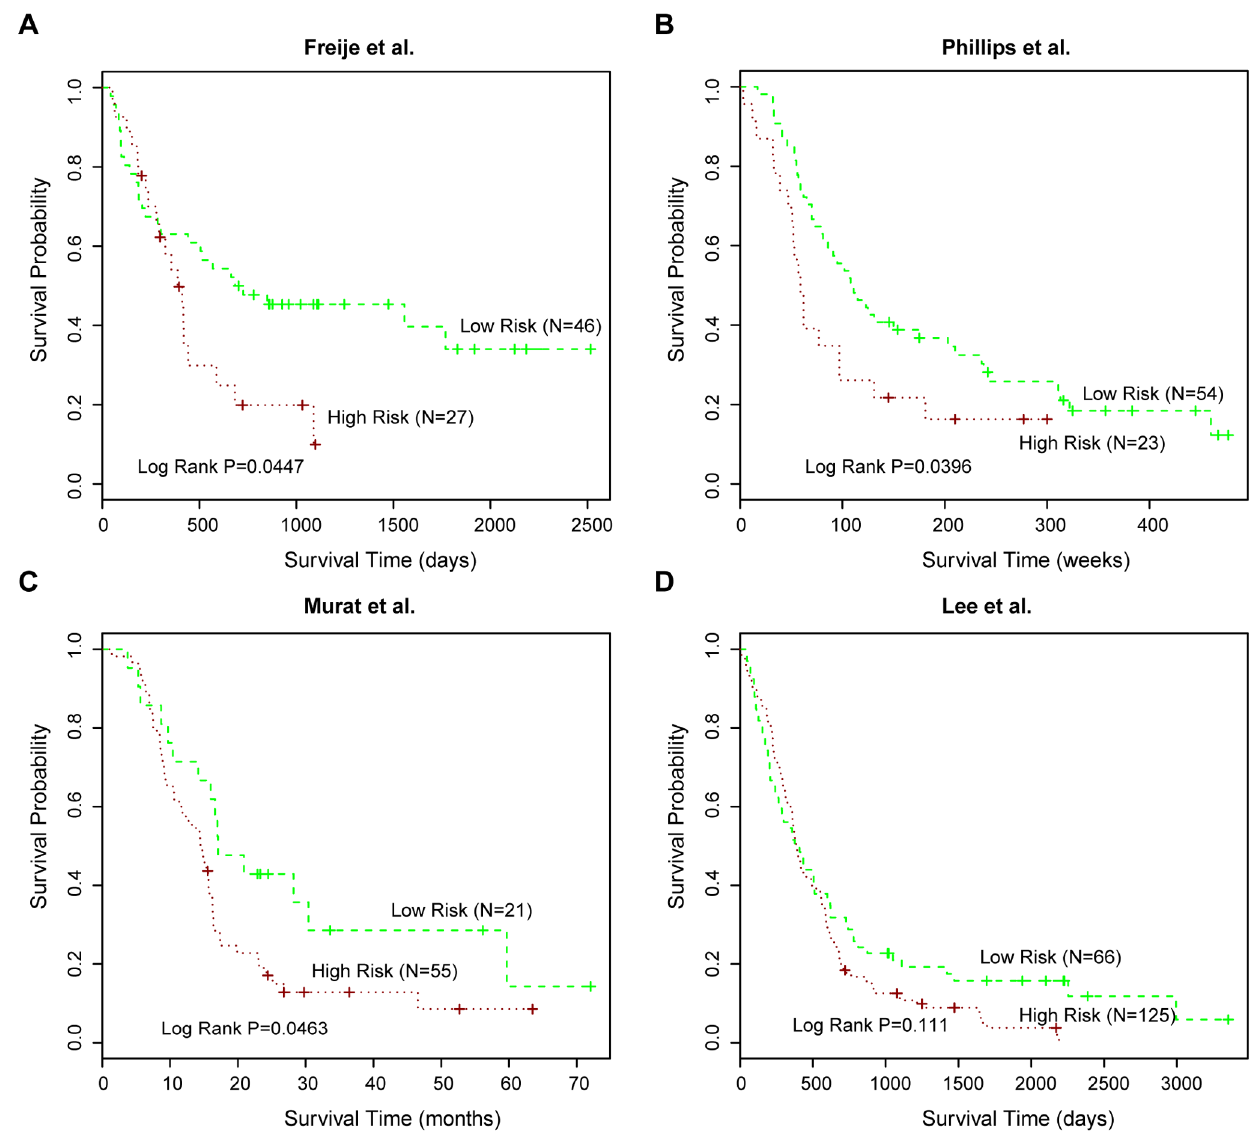
Figure 4. The gene signature from moduleS3 predicts clinical outcome of glioma datasets from GEO. The glioma datasets were respectively extracted from the studies of ( A ) Freije et al., ( B ) Phillips et al., ( C ) Murat et al., and ( D ) Lee et al.. The significance of clinical outcome difference between the low-risk and high-risk groups was estimated by K-M survival analysis. P-values were calculated by the log-rank test.